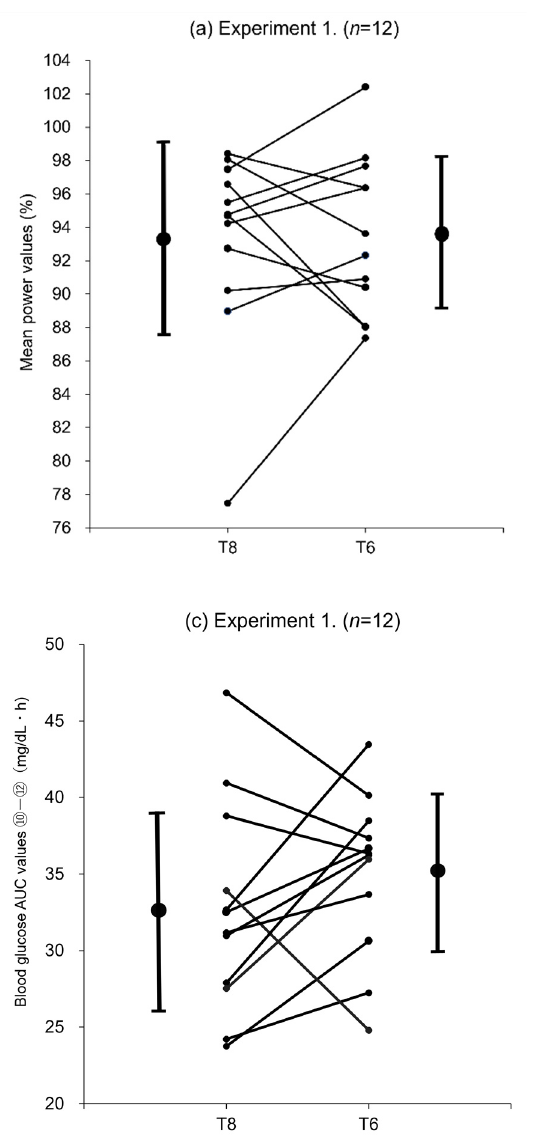
Figure 5. Individual changes in mean power values and blood glucose AUC. ( a ) Experiment 1: Changes in subjects’ mean power values (4th: T8 and T6) ( n = 12). ( b ) Experiment 2: Changes in subjects’ mean power values (4th: T6 and T4) ( n = 10). ( c ) Experiment 1: Changes in subjects’ blood glucose (AUC 10 (cid:13) – 12 (cid:13) : T8 and T6) ( n = 12). ( d ) Experiment 2: Changes in subjects blood glucose (AUC 10 (cid:13) – 12 (cid:13) : T6 and T4) ( n =